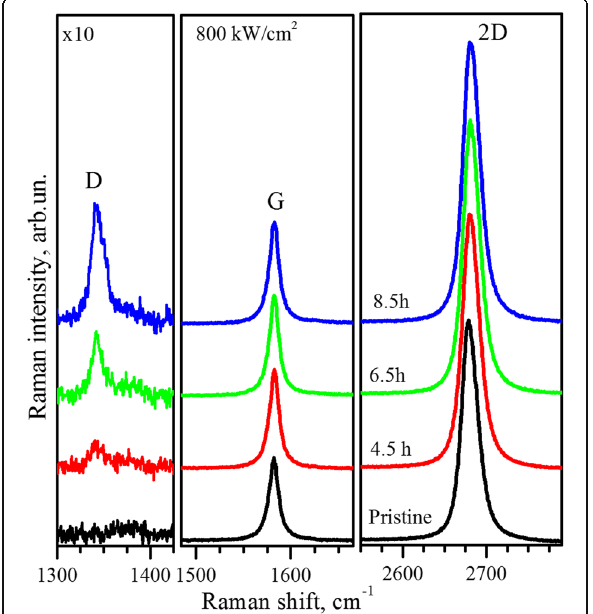
Fig. 2 Raman spectra. Raman spectra of the pristine single-layer graphene sample and after 4.5-, 6.5-, and 8.5-h exposure by 488-nm laser with power of 800 kW/cm 2 . Spectra are normalized to the intensity of the G